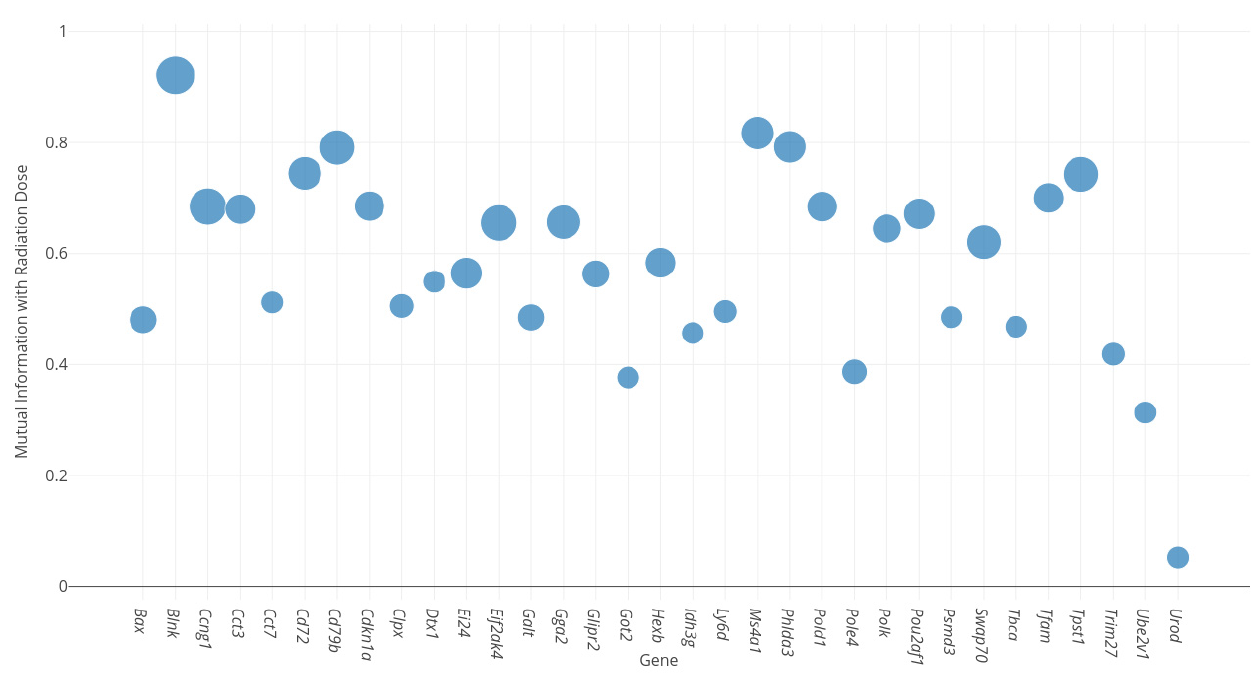
Figure 3. Scatter plot depicting the mutual information each gene’s expression shares with radiation exposure (averaged over GSE6874[GPL4783] and GSE10640[GPL6524]). The size of each circle is proportional to the frequency at which the gene appears in